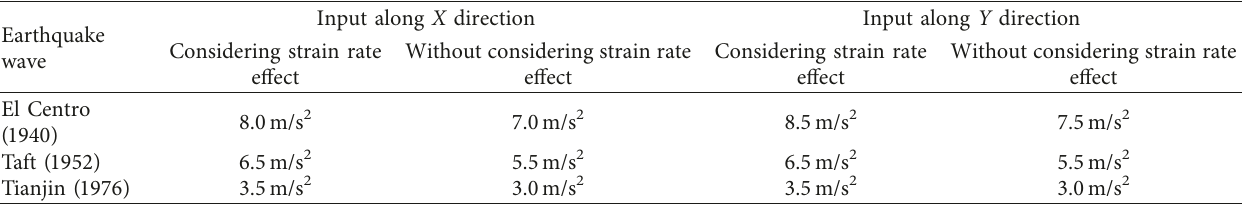
Table 4: Collapse-resistant capacity of the RC structure subjected to unidirectional excitation.